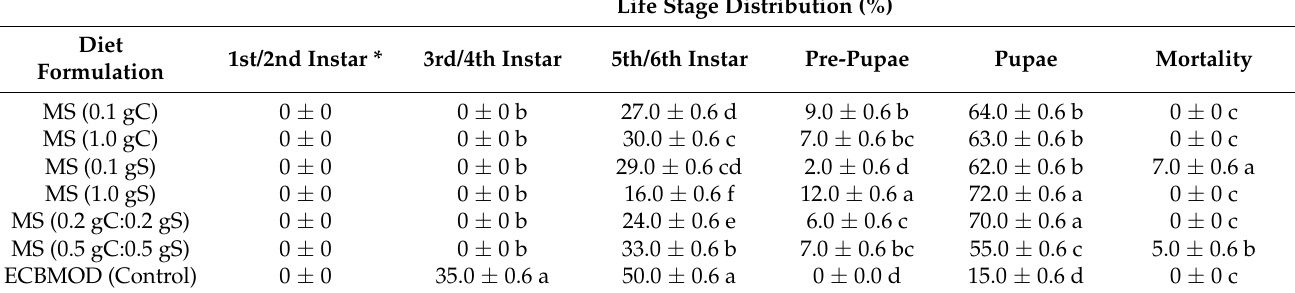
Table 4. Mean ( ± SE) distribution of Eldana saccharina life stages (percentage of the 3rd/4th instar larvae, 5th/6th instar larvae, pre-pupae, pupae and mortality) [ n = 30] surviving on the MS (0.1